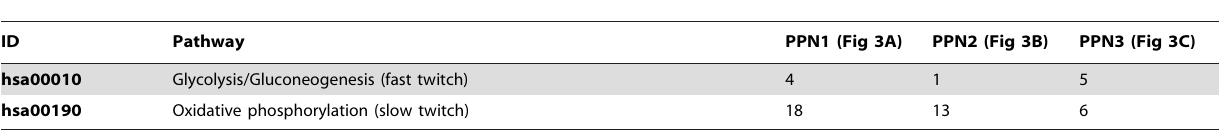
Table 8. Summary of muscle fibers’ cardinality.